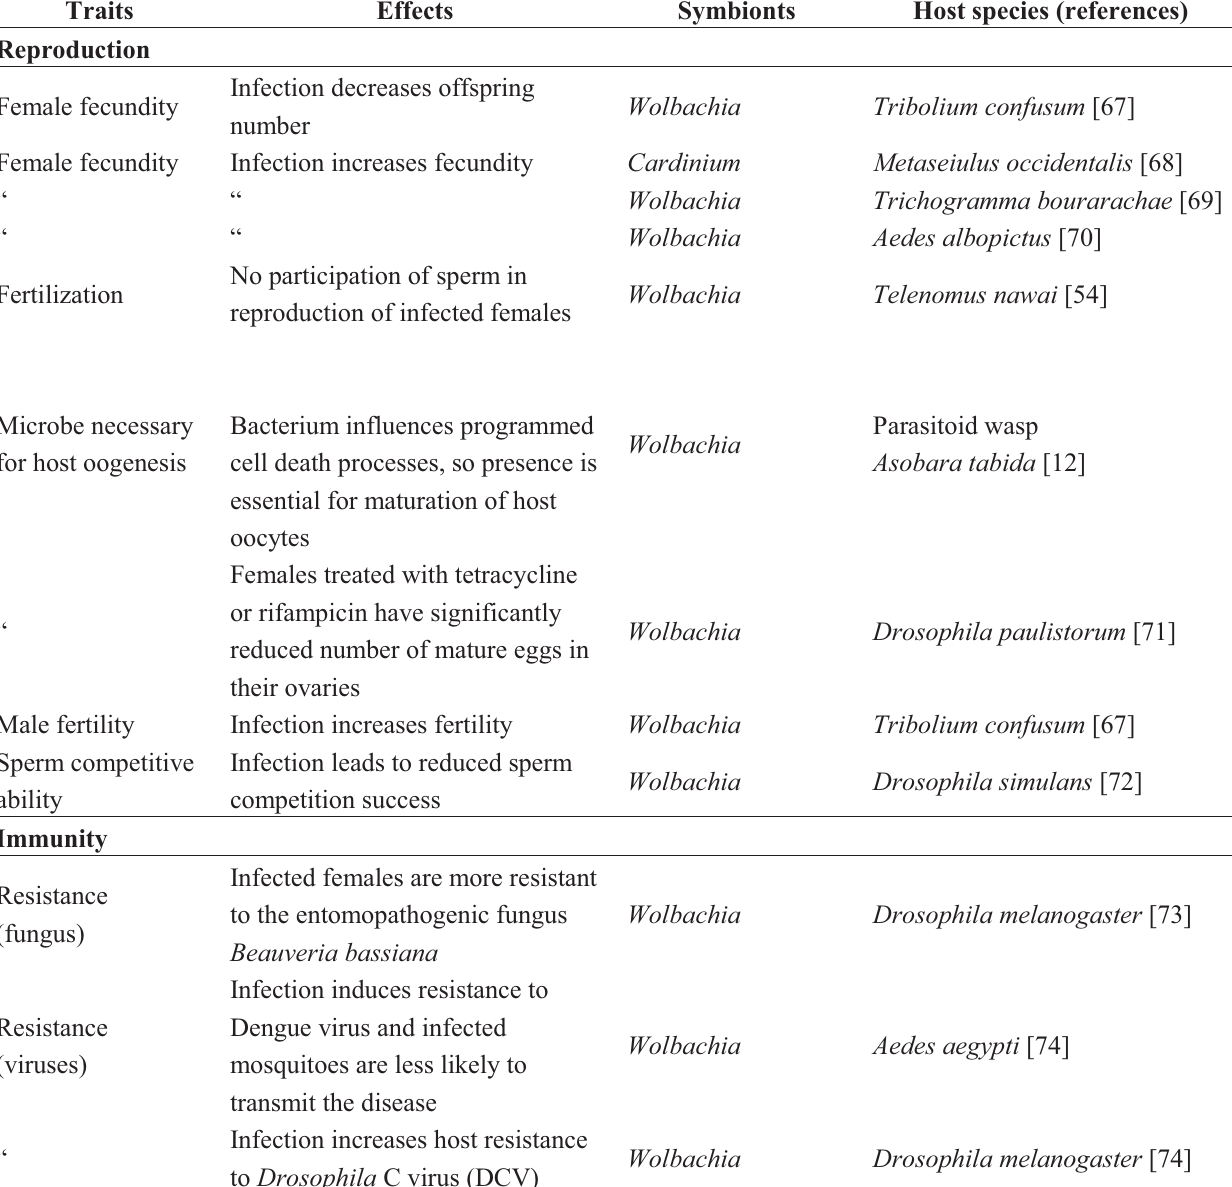
Table 2. Physiological effects of infection with vertically acquired, endosymbiotic bacteria in arthropod